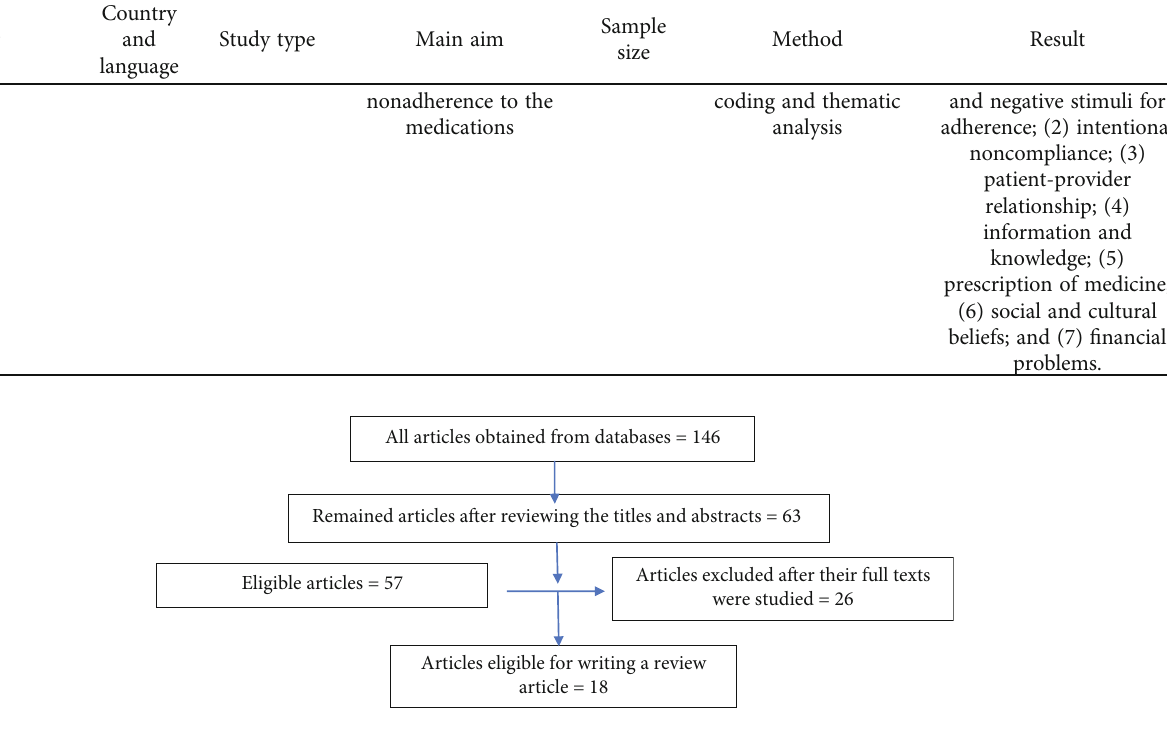
Figure 1: Flowchart of the selected